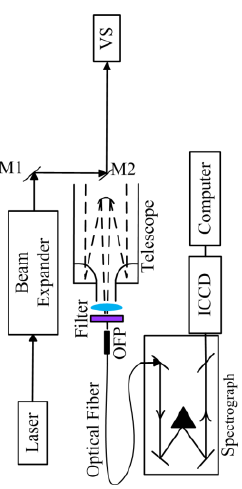
Figure 1. Schematic of LIF Lidar. M1 and M2 : completely reflecting mirror, VS : vegetation sample, OFB : optical fiber